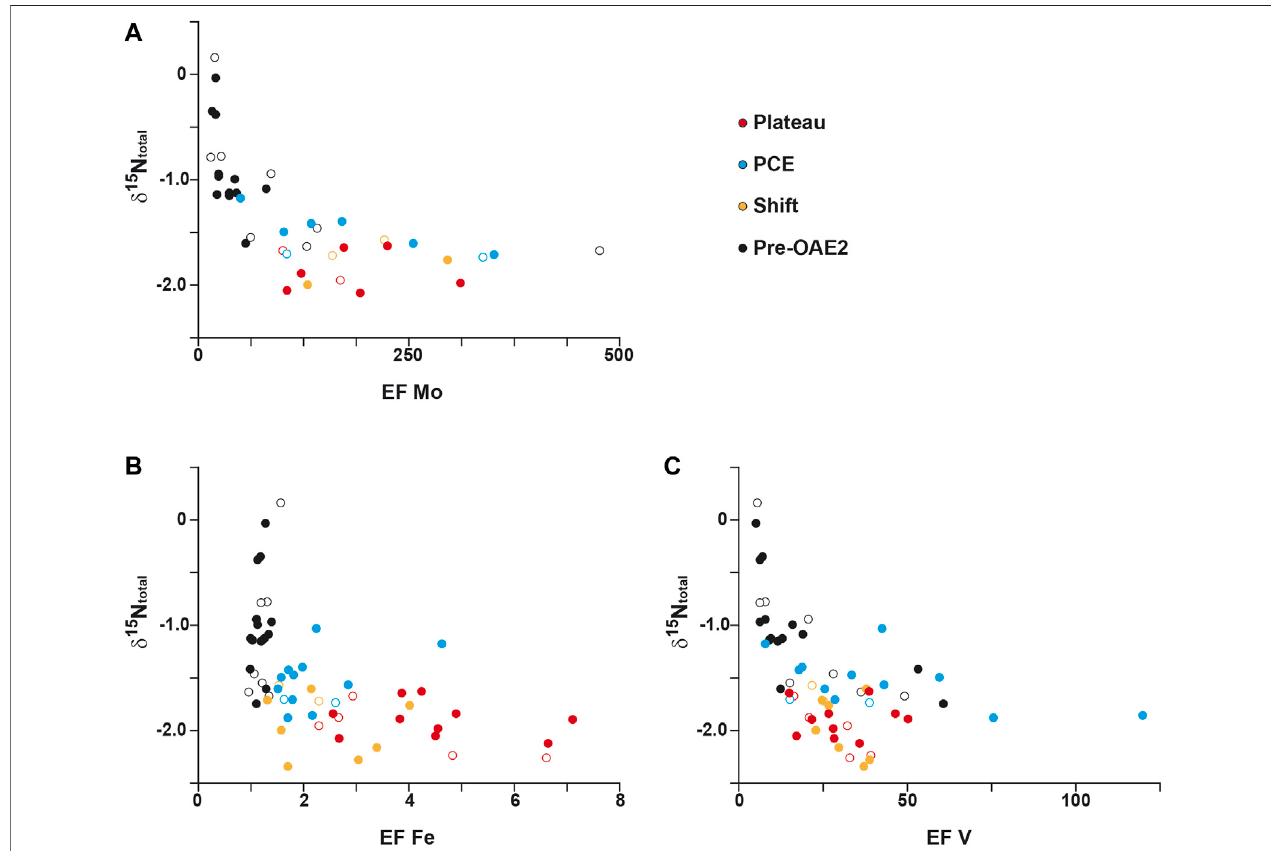
FIGURE9| Cross-plotofisotopicnitrogencompositions δ 15 N total versus,EFMo (A) ;EFFe (B) andEFV (C) Opensymbolscorrespondtothedatafromthestudyof Kuypers et al. (2002) for Mo and V and from unpublished data of H-J. Brumsack for Fe.